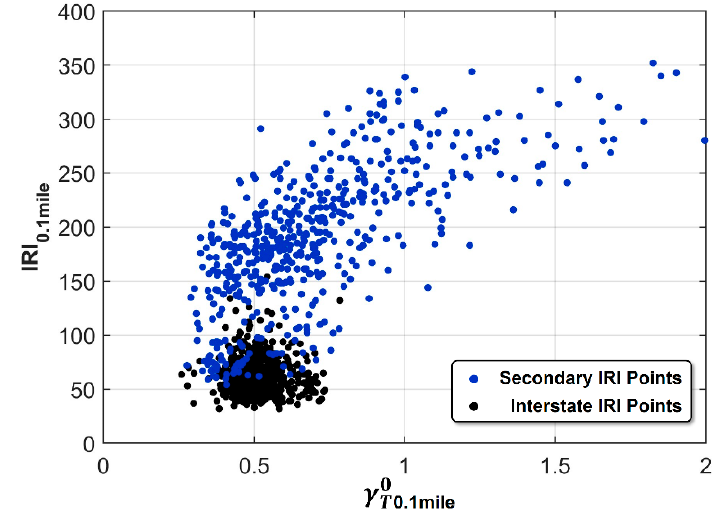
γ 0 scatter plot for IRI measurement locations from the training Figure 5. IRI vs. SAR 𝛾 (cid:3021)(cid:2868) scatter plot for IRI measurement locations from the training set. Figure 5. IRI vs. SAR T